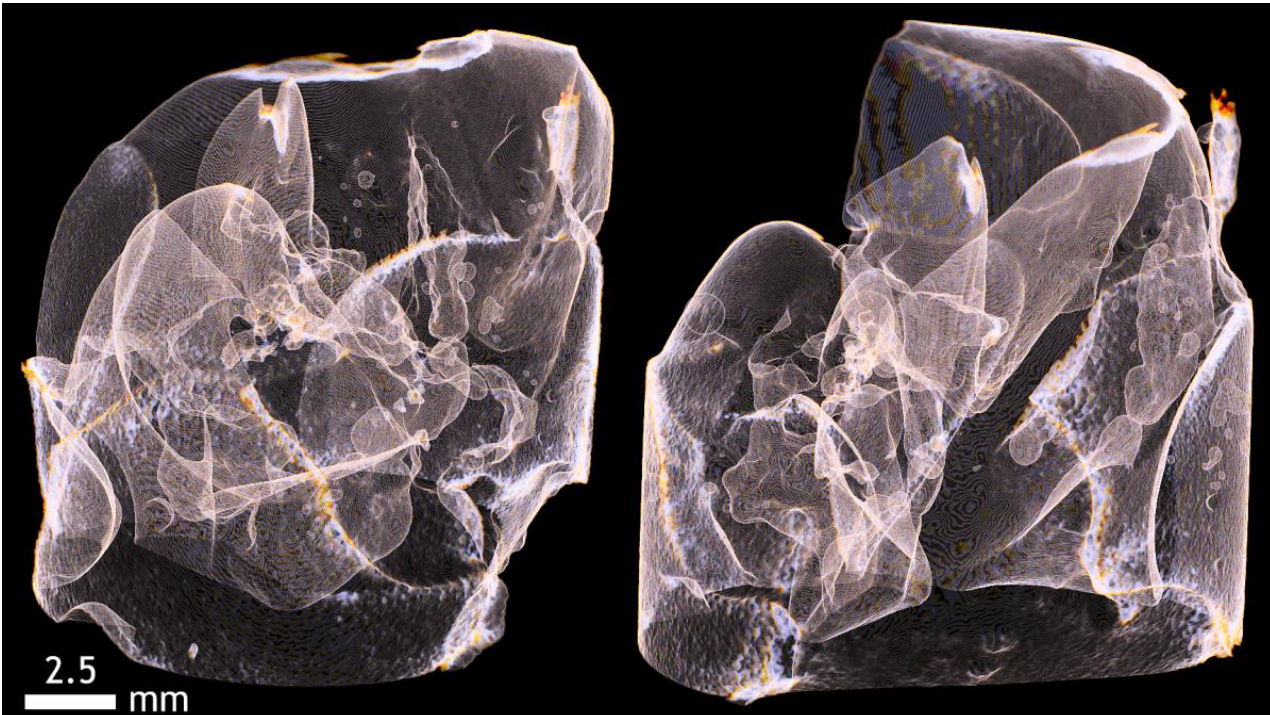
To emphasize soft tissue organs loaded in a solution of dissolved potassium iodide in in 20% ethanol solution, additional LUTs were designed and optimized. 20% ethanol solution, additional LUTs were designed and optimized.